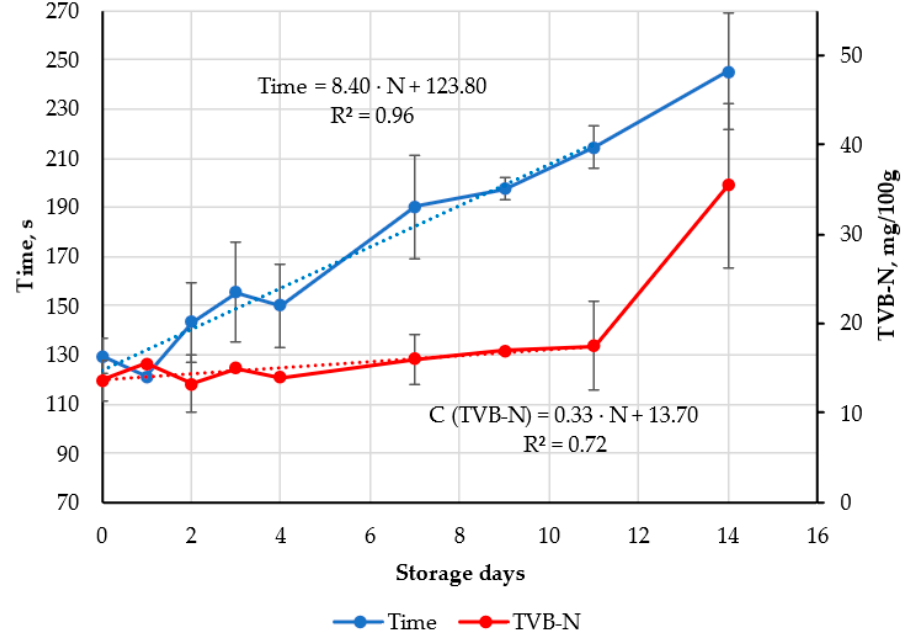
Figure 6. Averaged index Time obtained with FPMLC device and TVB-N content values for farmed trout during storage. trout during